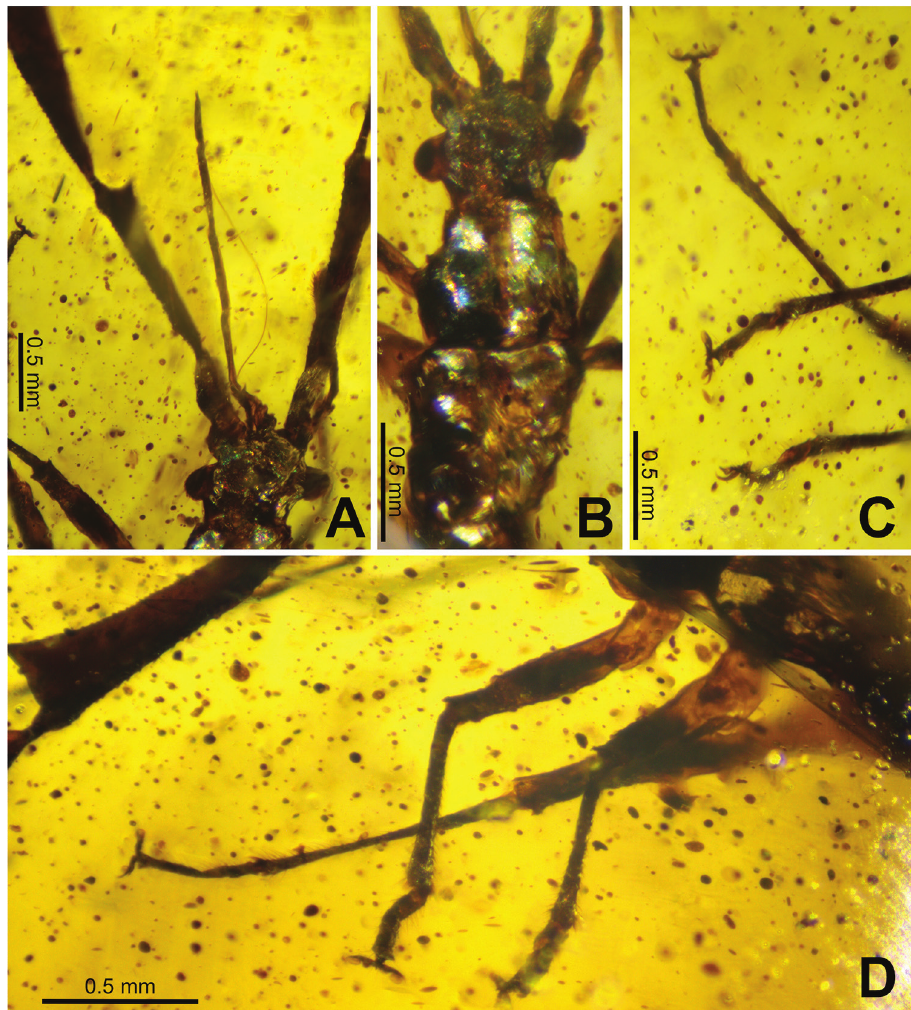
Figure 4. Ferriantenna excalibur gen. et sp. nov. holotype A extended labium with stylet exposed to the right B head, pronotum, and mesonotum, dorsal C left tarsi and distal ends of the tibiae D legs on the left side,